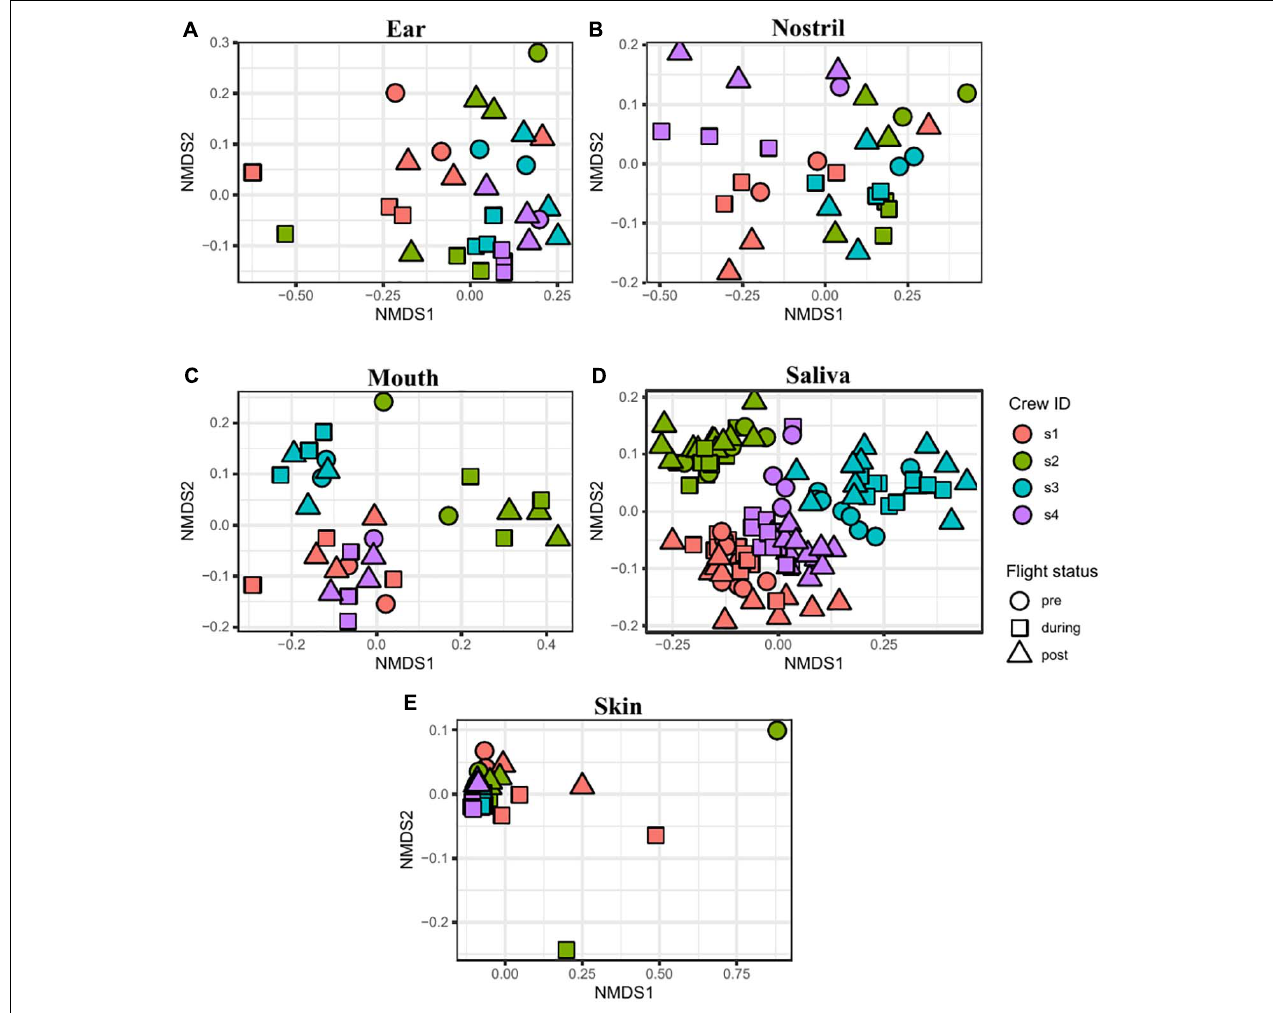
FIGURE 6 | NMDS plots depicting the Jaccard distance between samples. Ear (A) , nostril (B) , mouth (C) , saliva (D) , and skin (E) samples are shown grouped by astronaut (Astronaut 1 or s1, red; s2, green; s3, blue; s4, purple) and flight status (pre, circle; during, square; post,